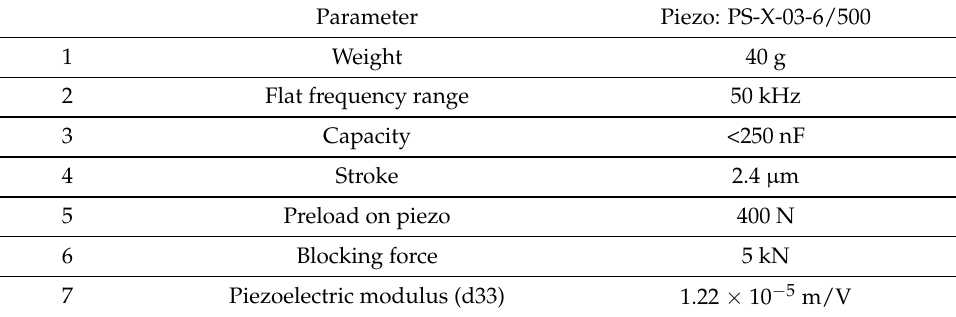
Table 2. Piezoelectric exciter